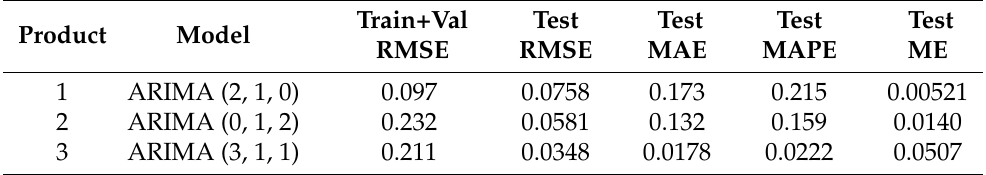
Table 5. Selected ARIMA models for the three products, associated RMSE on the entire train- ing+validation set, and performances on the test set (RMSE, MAE and MAPE). Please note that MAPE is computed for price time series p t , not for the ∆ ( t ) time series.